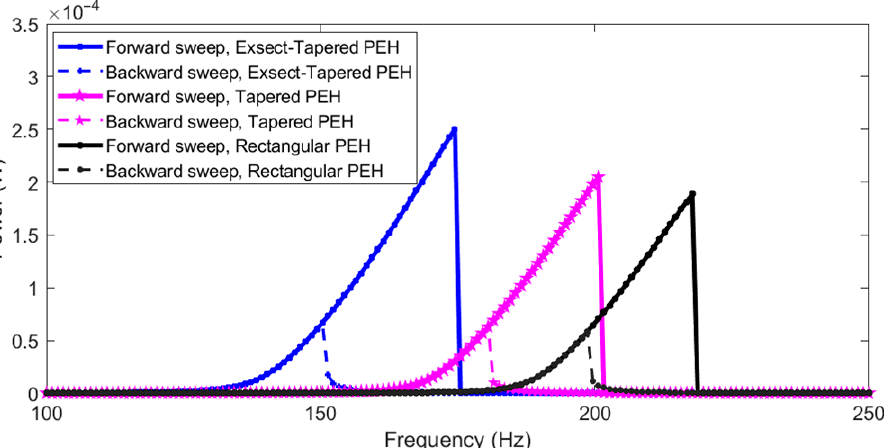
Figure 10. Numerically simulated frequency response (nonlinear) of the PEHs for an input excitation of 0.9 g . Solid lines represent forward sweep, and dashed lines represent backward sweep.